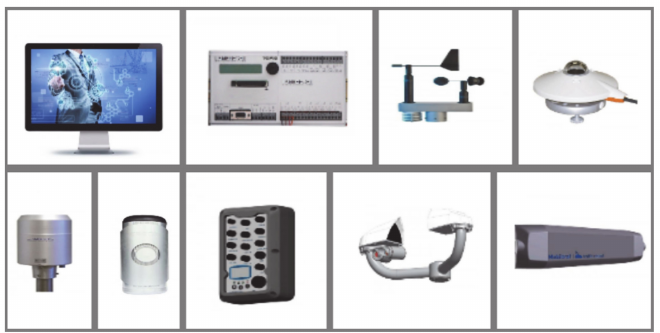
Figure 7. Image-list of compatible commercial products to set-up the system infrastructure. The system is capable of collecting the critical information needed to a real-time implementation of the route optimization strategy. Onthetop,fromlefttoright: monitoringmanagementandcontrolsoftwareplatform,meteorological station unit, wind speed relative humidity and atmospheric pressure sensors, solar irradiance sensor. On the bottom, from left to right: rain gauge, environmental sensor (CO, NO 2 , O 3 , PM10), multifunction local control unit, visibility sensing unit, microwave traffic counter and traffic